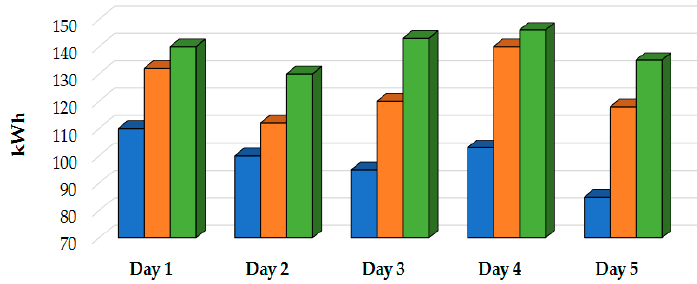
Figure 13. The daily energy demand shifted from the high to lower price electricity rate.